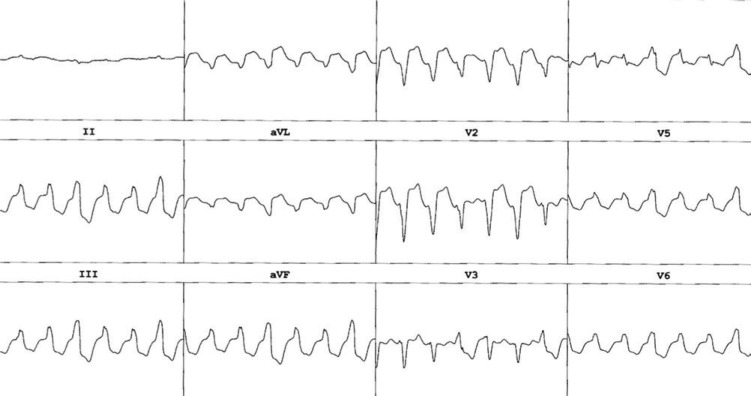
A 12-lead ECG of monomorphic VT, seen in a patient with biventricular non-compaction.